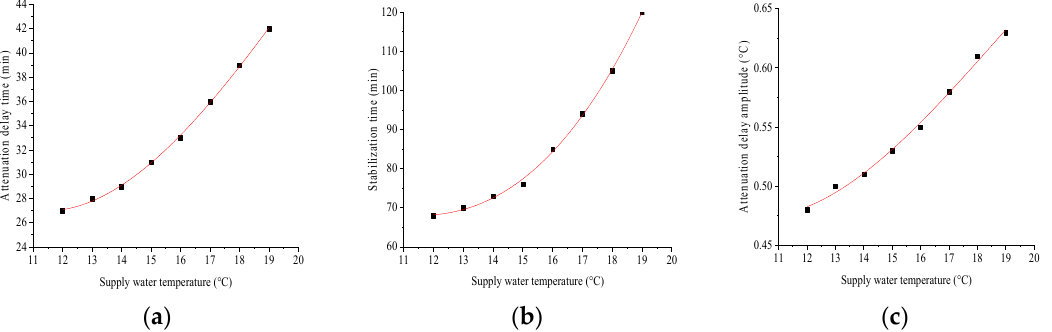
Figure 9. Change in attenuation delay time ( a ), stabilization time ( b ) and attenuation delay amplitude ( c ) of indoor air with different supply water temperature of the CTRC system.